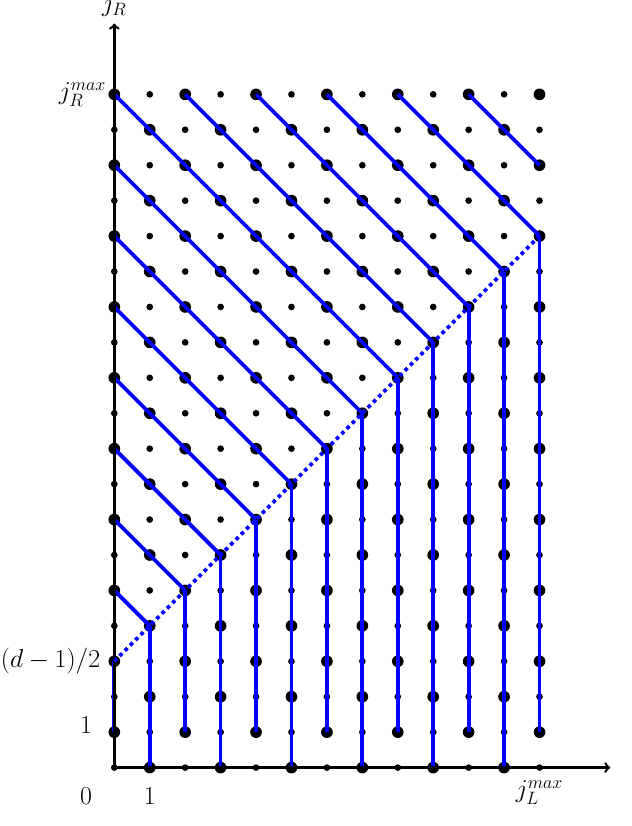
Figure 9 . Strict total order for ( j L ; j R ) at general degree d